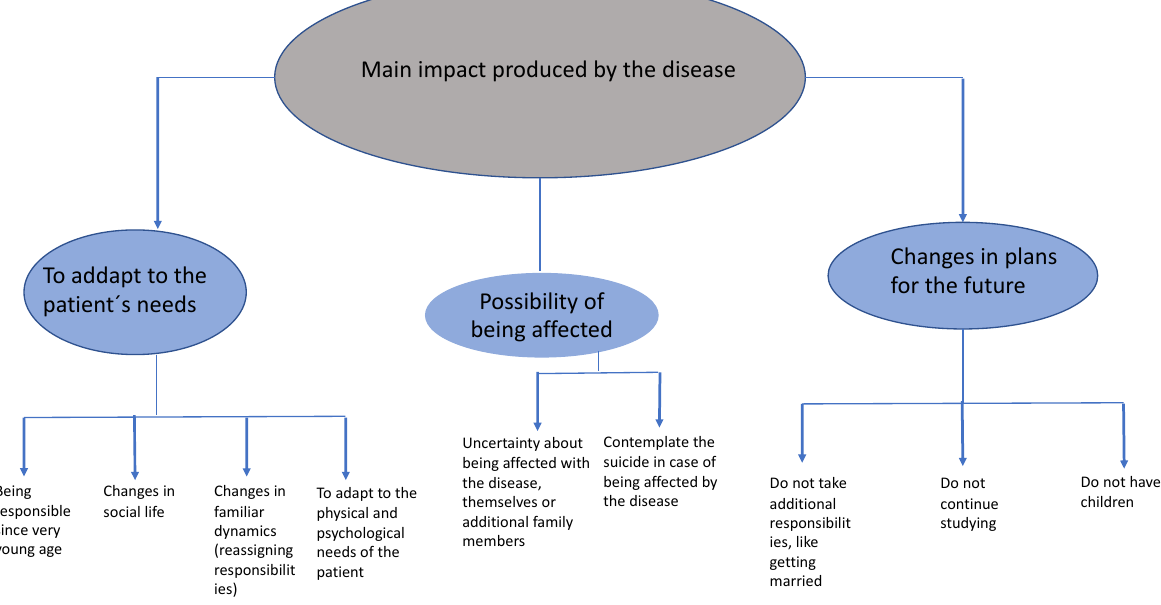
Figure 1. Changes or impacts produced by the disease.